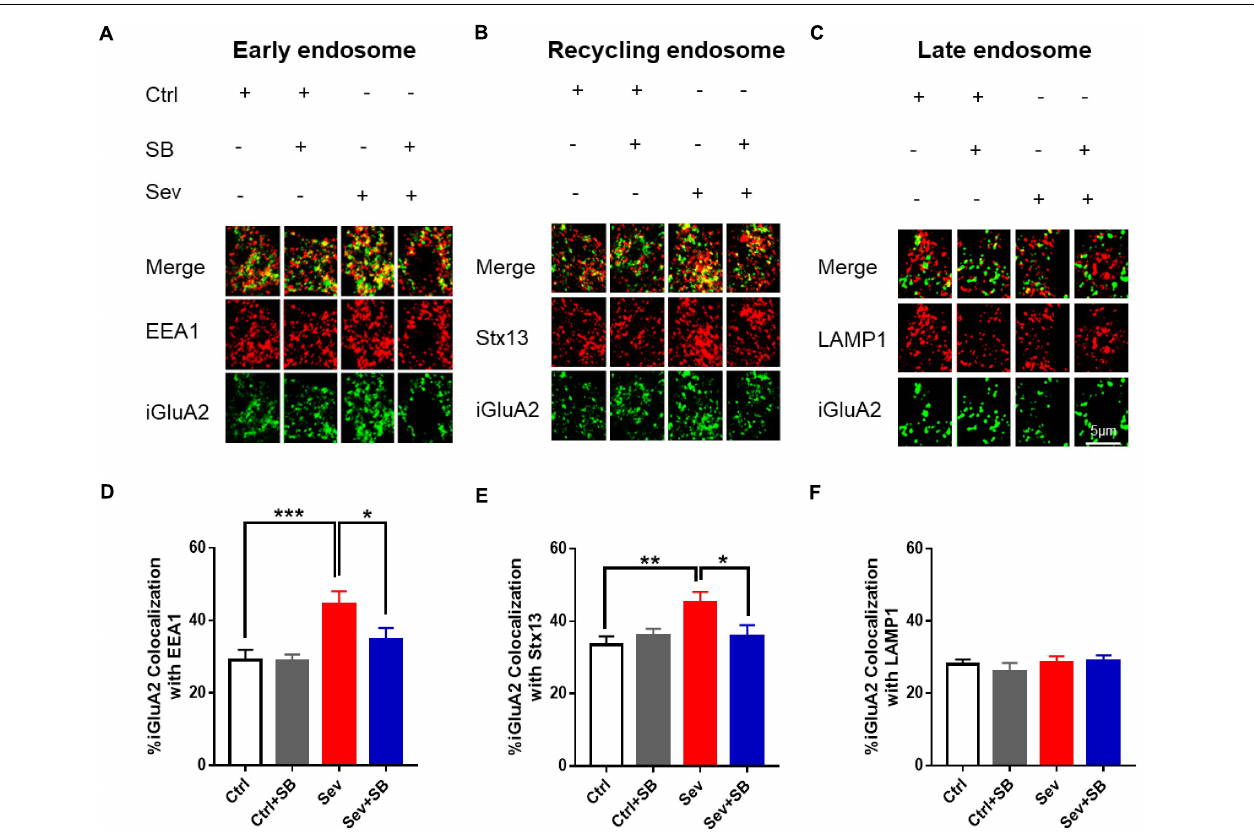
FIGURE 6 | Pretreatment with TRPV1 antagonist SB 366791 reversed the sevoflurane-induced accumulation of internalized AMPAR in endosomes. (A) Co-localization of internalized GluA2 (iGluA2, green) and EEA1 (red) in the cell bodies of hippocampal neurons from the Ctrl and Sev cultures treated with TRPV1 antagonist SB 366791 (10 µ M). (B) Co-localization of iGluA2 and Stx13 (red). (C) Co-localization of iGluA2 and LAMP1 (red). (D) Quantification of (A) . [3 cultures per group, one-way ANOVA, F ( 3 , 82 ) = 6.2, p = 0.0008]. (E) Quantification of (B) . [3 cultures per group, one-way ANOVA, F ( 3 , 80 ) = 3.8, p = 0.0129]. (F) Quantification of (C) [3 cultures per group, one-way ANOVA, F ( 3 , 51 ) = 0.5, p > 0.05]. Data are presented as the mean ± SEM. ANOVA followed by Bonferroni post hoc test. * p < 0.05; ** p < 0.01; *** p < 0.001. Ctrl, control; Sev, sevoflurane; SB, SB